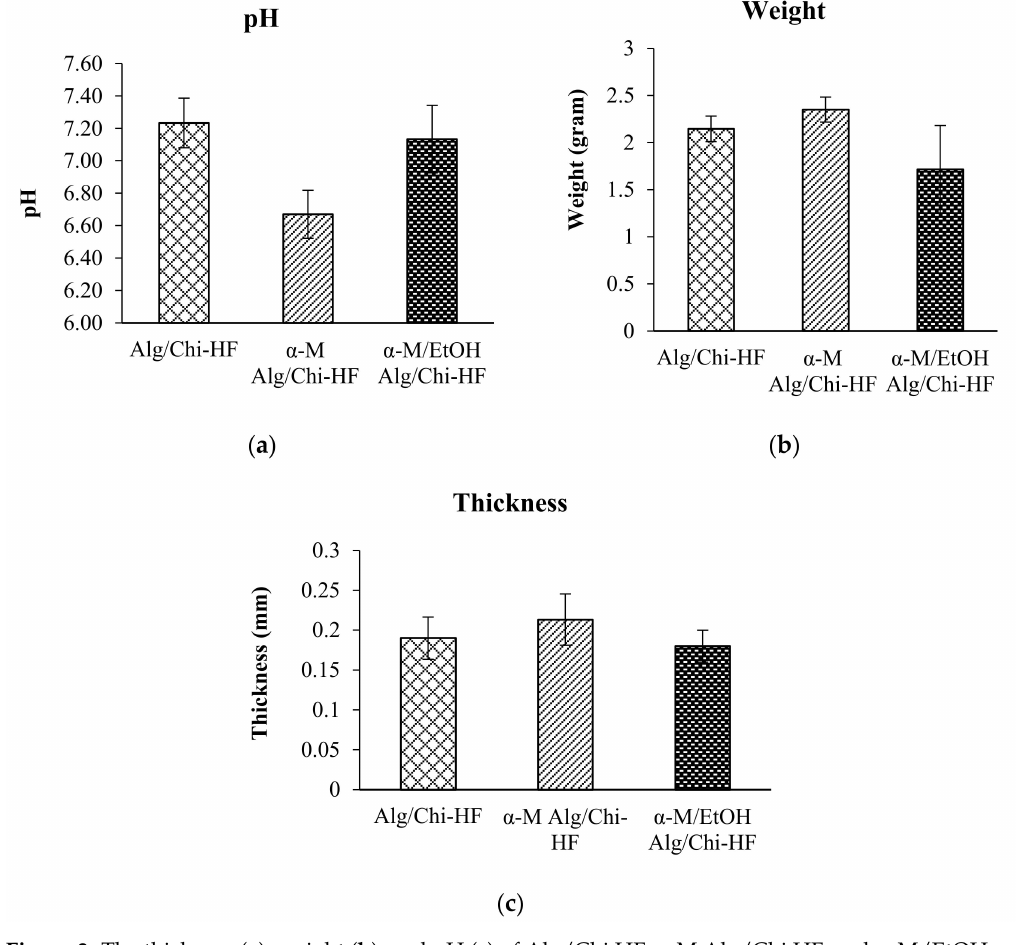
6.6 ± 0.15, and 7.3 ± 0.21, respectively (Figure 3c). Based on the statistical test results, there is no significant difference between Alg/Chi HF, α -M Alg/Chi HF, and α -M/EtOH Alg/Chi HF ( α =